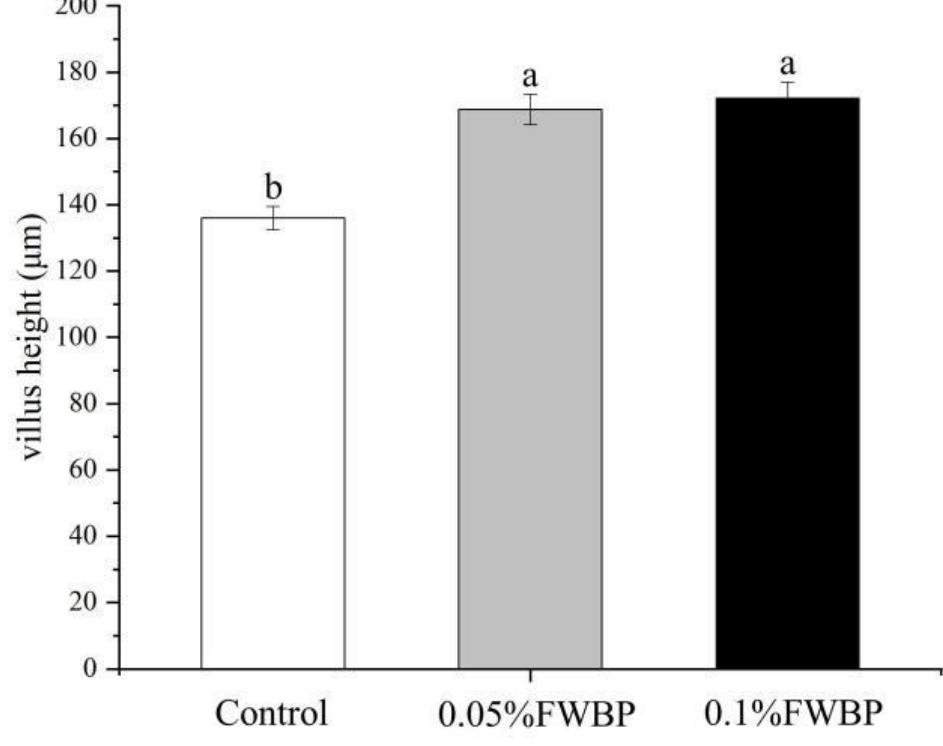
Figure 4. The effects of FWBP on villus height and crypt depth in the intestine. FWBP: Fermented wheat bran polysaccharides. Different lowercase superscript letters denote statistically significant differences among different groups ( p < 0.05).